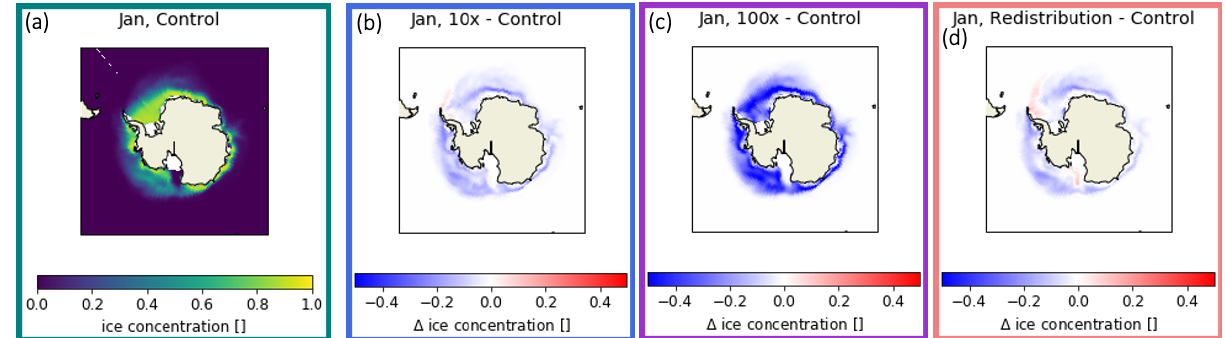
Figure 9. Maps of January Southern Hemisphere sea ice concentration (a) in the control run and relative change in the (b) 10 × , (c) 100 × , and (d) redistributed lateral melt runs.